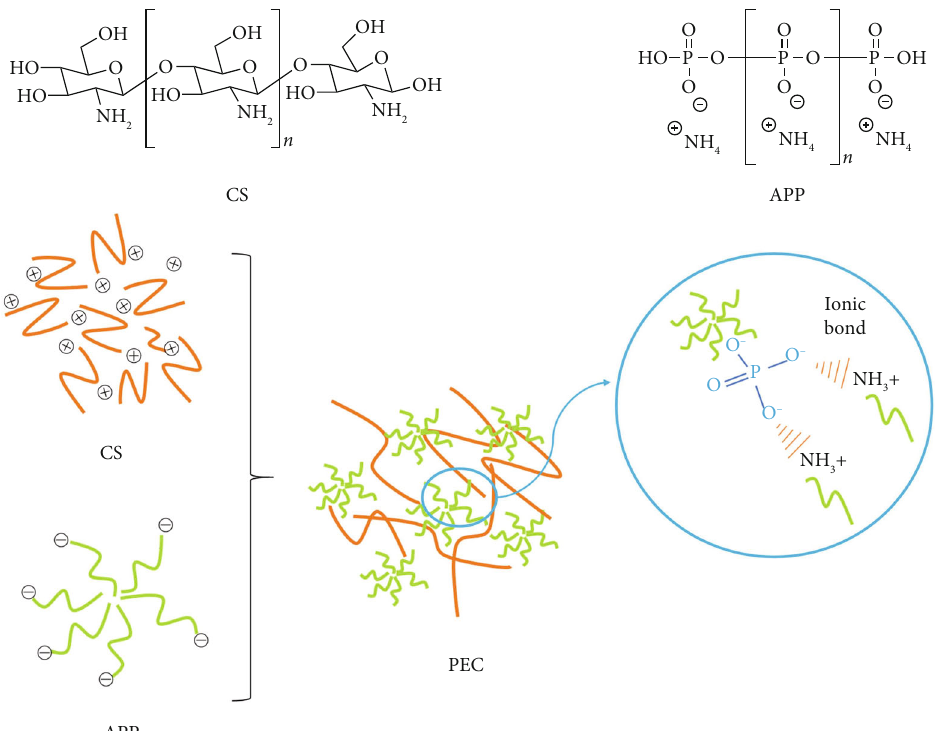
Figure 3: Schematic illustration of the interaction between APP and